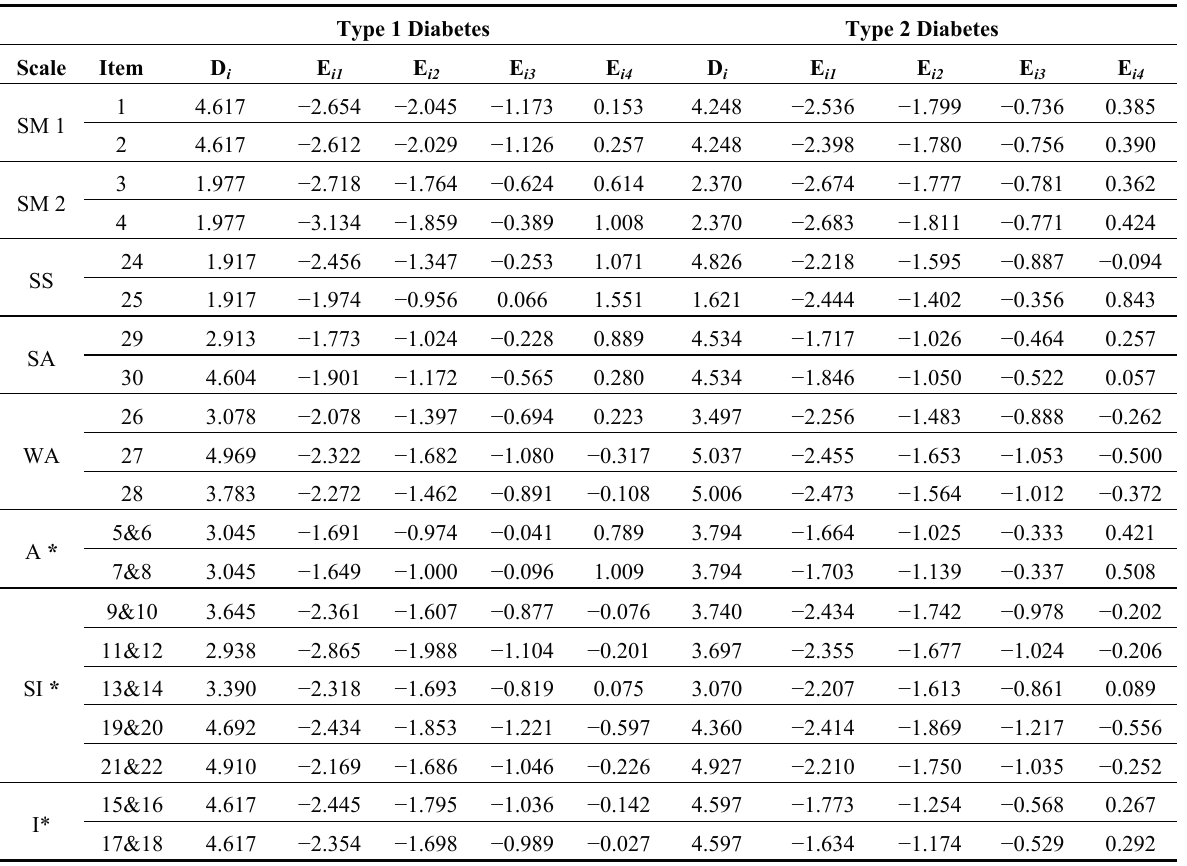
Table A2. Fitted graded response models for type 1 and type 2 diabetes, respectively (discriminant parameter D and extremity parameters E ), for Self-Management Skills i ik (SM 1), Self-Management Ability (SM 2), Sense of Security (SS), Social Activities (SA),